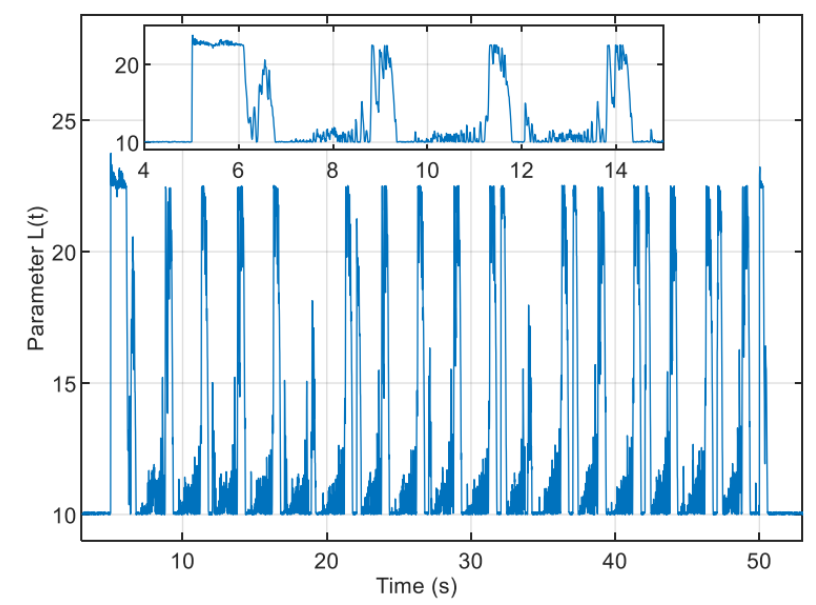
Figure 6. Adaptive effect of control parameter L